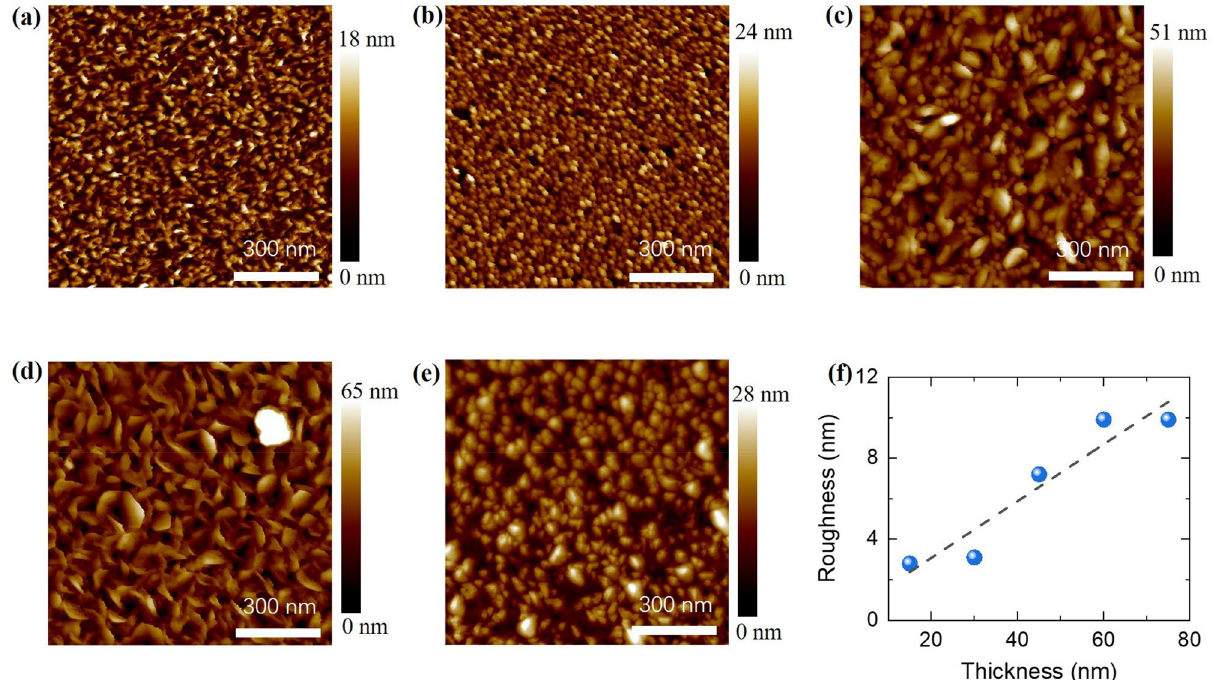
Figure 4. AFM phase images of the CCO films with thickness of (a) 15 nm, (b) 30 nm, (c) 45 nm, (d) 60 nm and (e) 75 nm; (f) shows the variation of films’ roughness with